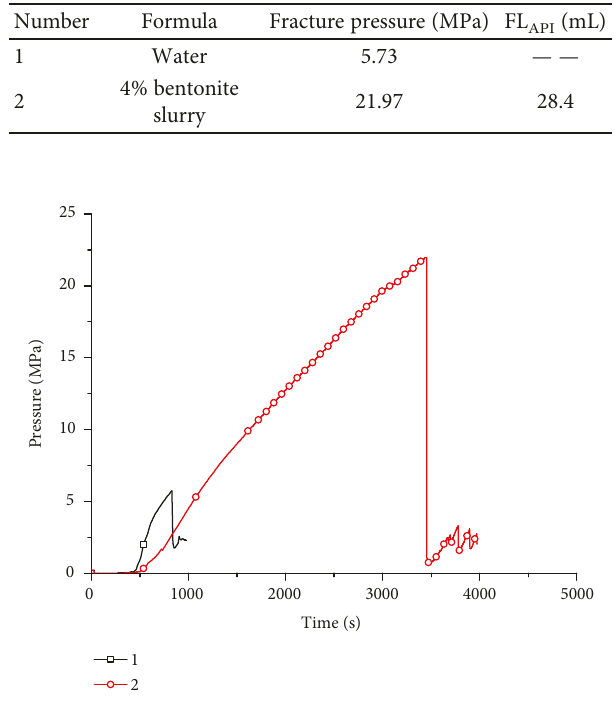
Figure 7: Pressure curves of fracturing core by water and a bentonite slurry.